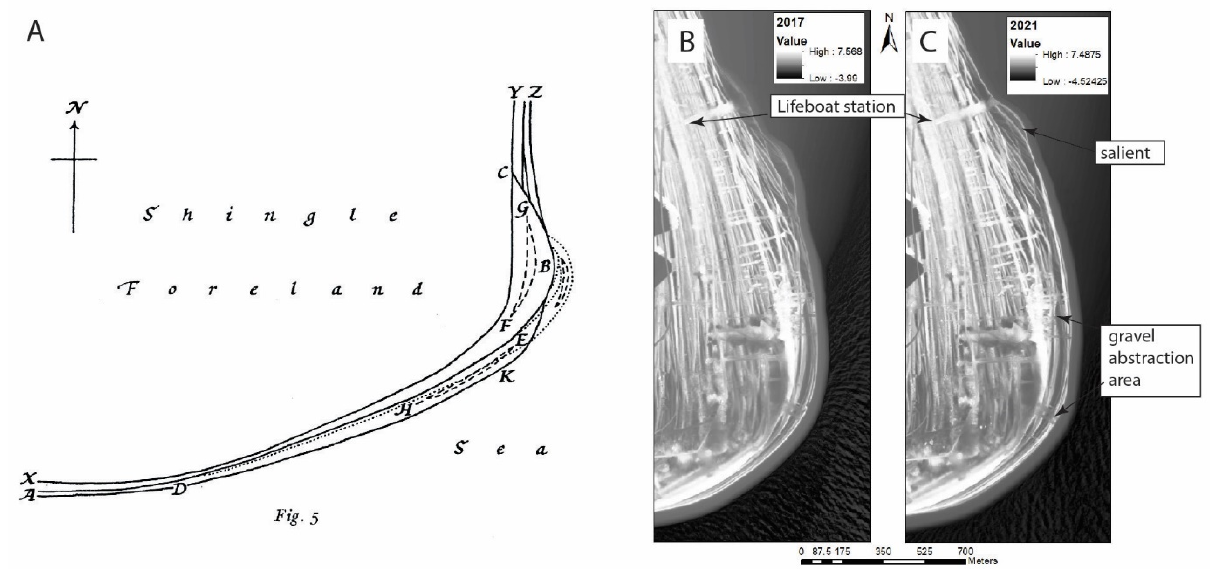
Figure 9. Salients close to the apex of Dungeness; ( A ) as illustrated by Lewis (1932). ( B ) Lidar data from 2017 and ( C ) Lidar data from 2021 showing the recent development of salients and echelon beach ridge formation.